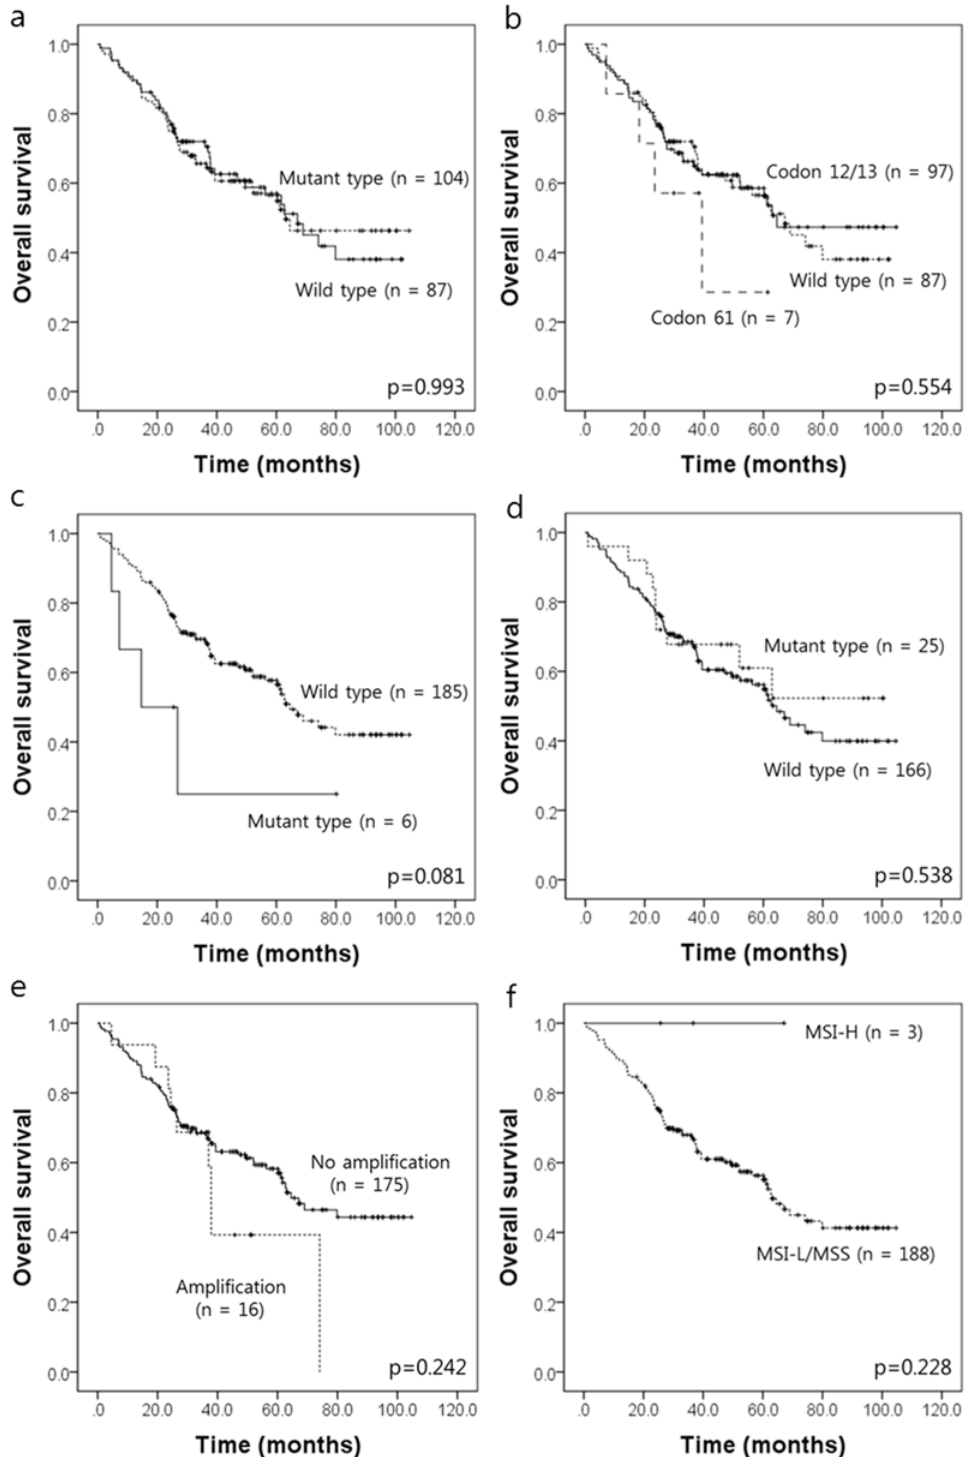
Fig 1. Kaplan-Meier survival estimate graphs of overall survival (OS) in 191 advanced CRC patients according to KRAS mutations status (a), locations of KRAS mutations in advanced CRC patients (b), BRAF mutations (c), PIK3CA mutations (d), HER2 amplifications (e), and MSI status (f).